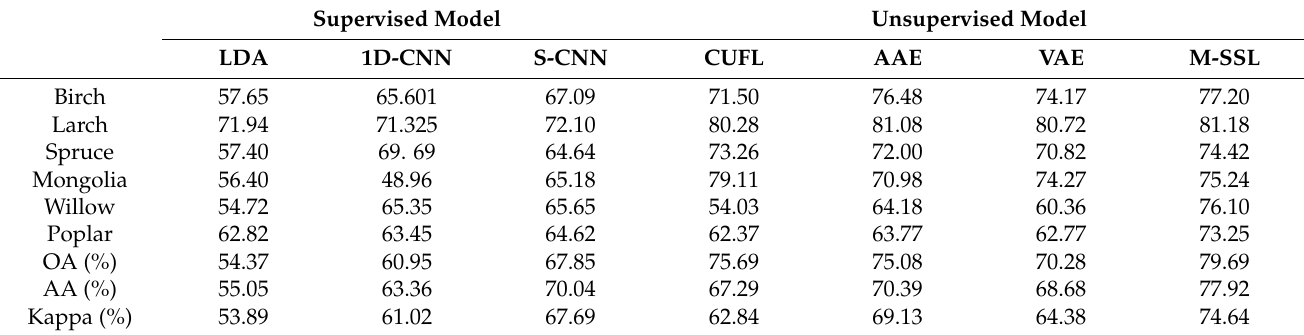
Table 12. The classification accuracy of models for dataset (2).